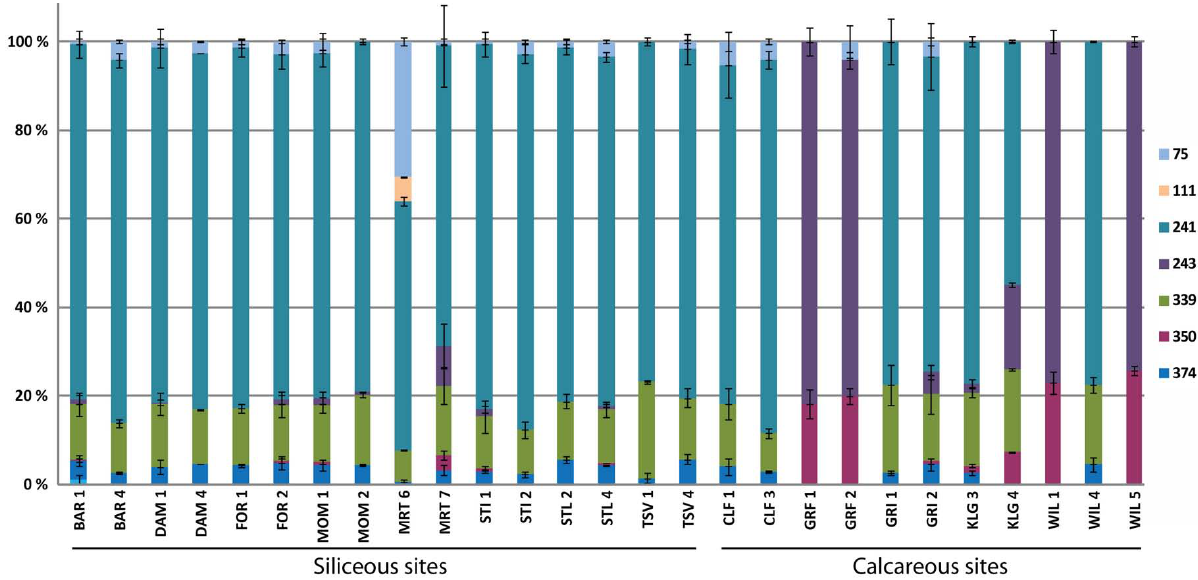
Fig. 4. Bar diagrams of pmoA -based T-RFLP fingerprint patterns obtained from all 27 subsamples representing the 13 different glacier forefields. The T-RFLP patterns were generated using the primer set A189f-A682r in first-round PCR and the primer set pmoA206f-mb661 in nested second-round PCR. The percentage abundances (mean ± sd; n = 3) of 7 distinguishable T-RFs are indicated by different